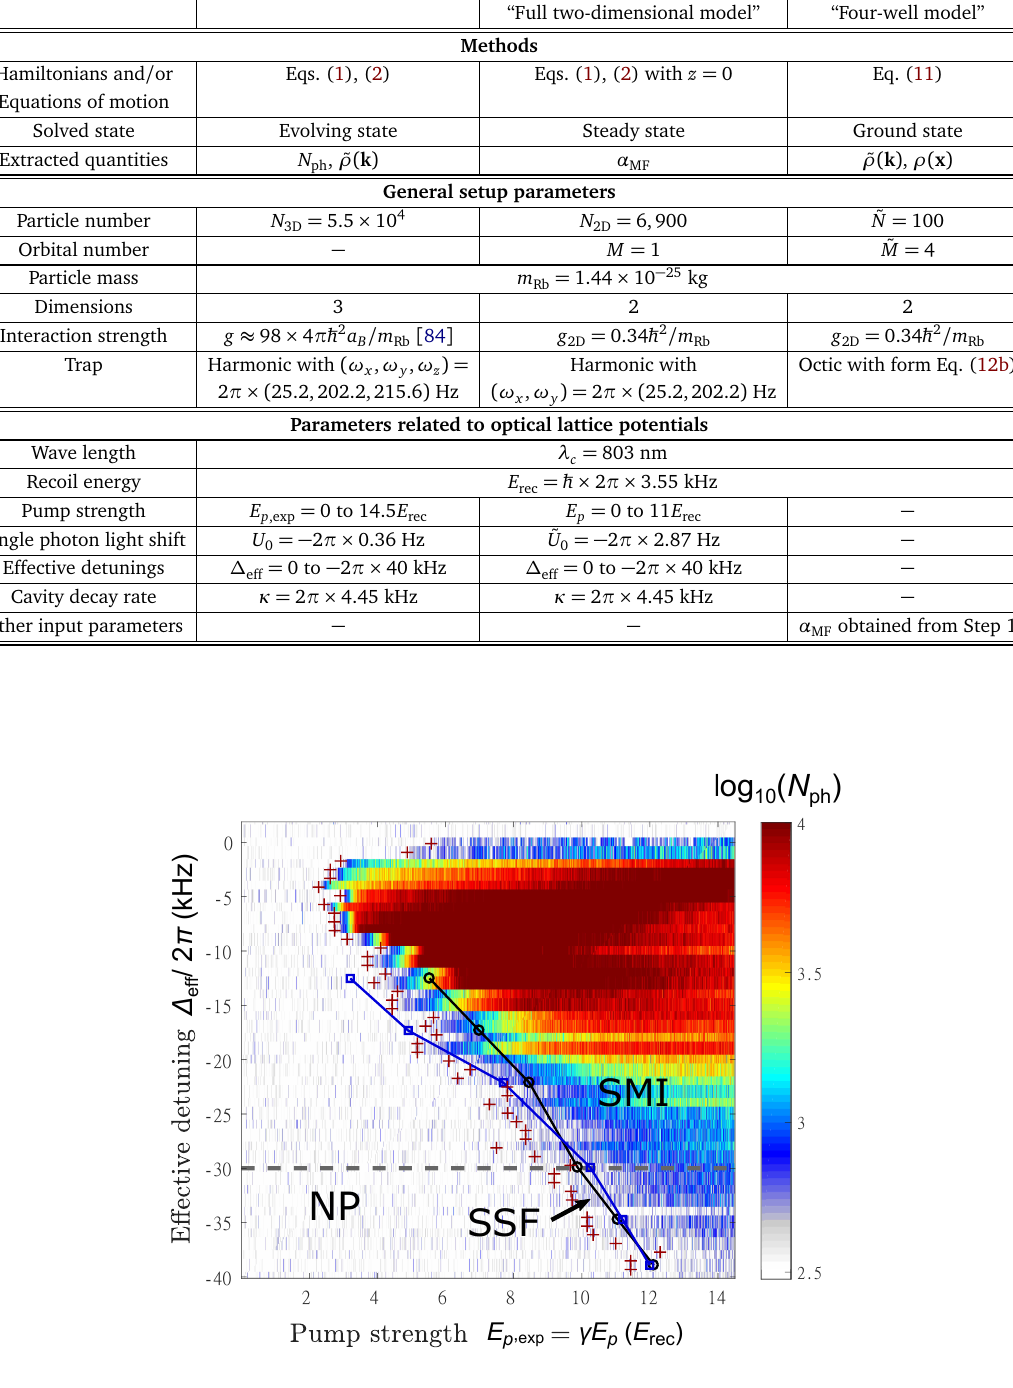
Figure 7: Experimental phase diagram for the fast ramping protocol with ramping = 20 ms. The photon number is shown as color scale in the background, and time T r the NP–SSF boundary is shown as dark red crosses. The SSF–SMI boundary is shown as black circles. For comparison, the simulated SSF–SMI boundary is shown by the blue squares. The experimental and simulation data for the SSF–SMI boundary are also used for the steady-state phase diagram in Fig. 2 of the main